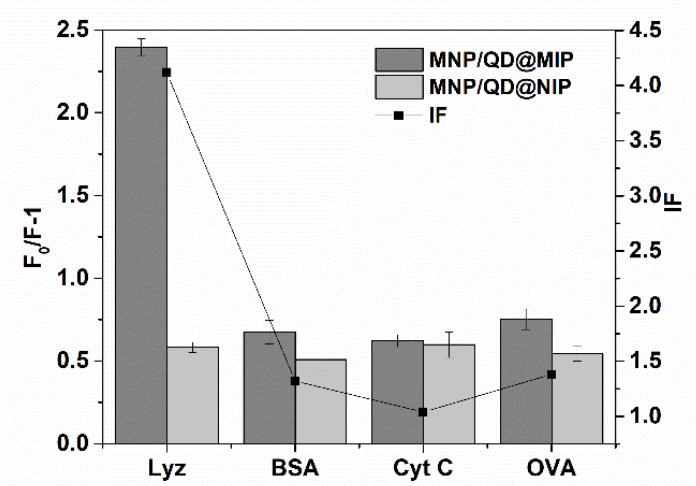
Figure 6. The fluorescence quenching efficiency (F 0 /F − 1) and the imprinting factor (IF) of MNP/QD@MIP sensor for lysozyme, BSA, Cyt c and OVA.